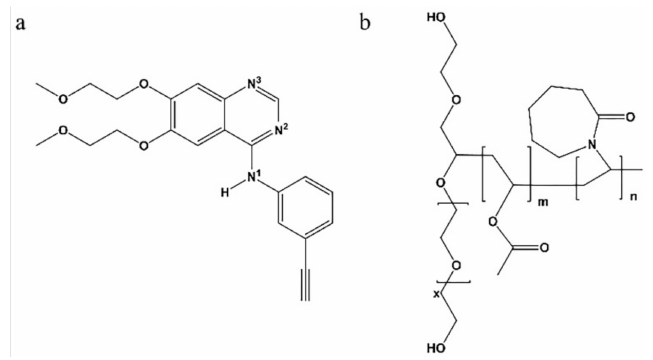
Figure 1. The molecular structures of ( a ) ERL and ( b )